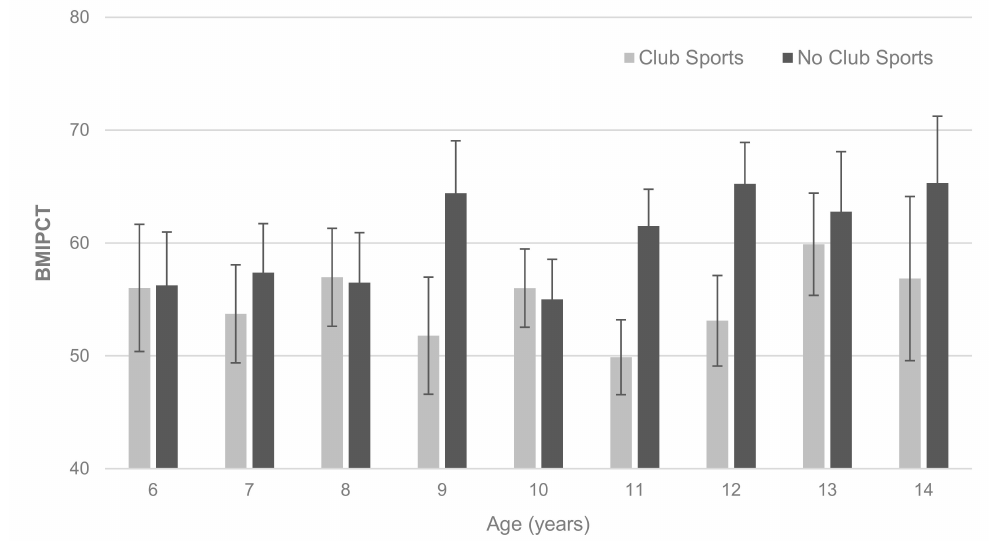
Figure 1. BMIPCT by age and club sports participation. Values are mean with 95% CI.